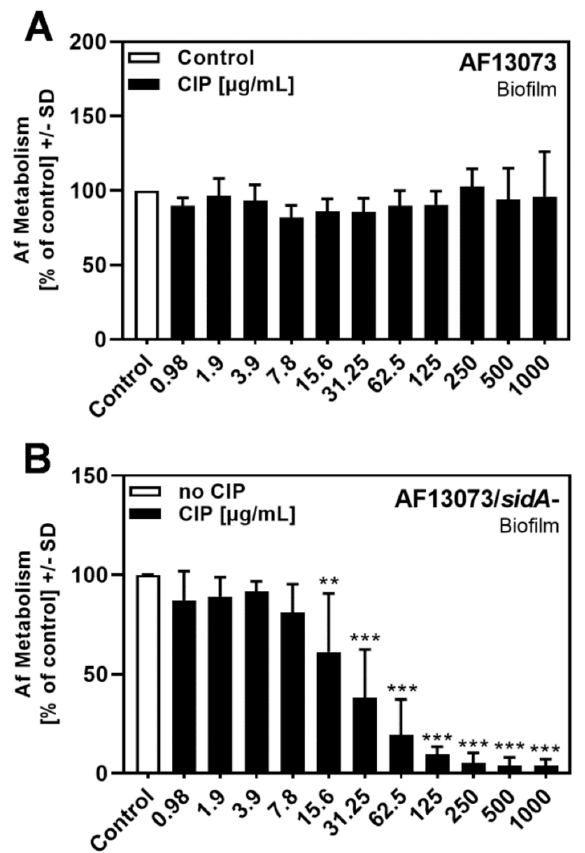
Figure 1. CIP reduces A. fumigatus biofilm metabolism in the absence of siderophores. CIP (final concentrations 0.98–1000 µ g/mL in RPMI 1640 medium, x-axis) was combined with ( A ) AF13073 conidia (10 5 conidia/mL in RPMI 1640 medium) or ( B ) AF13073/ sidA - conidia (2 × 10 5 conidia/mL in RPMI 1640 medium). As the siderophore-deficient mutant has slower growth, using double the amount of conidia assured similar growth to the wildtype in the untreated controls for both fungi. Assay plates were incubated at 37 ◦ C overnight. Fungal metabolism was measured by an XTT assay. The metabolism in the presence of RPMI alone was regarded as 100%, and was compared to each supernatant dilution. Statistical analysis, 1-way ANOVA: two or three asterisks = p ≤ 0.01 or p ≤ 0.001, respectively. Comparison: RPMI (white bar) vs. all other bars (black bars). A: n = 6–7; B: n =